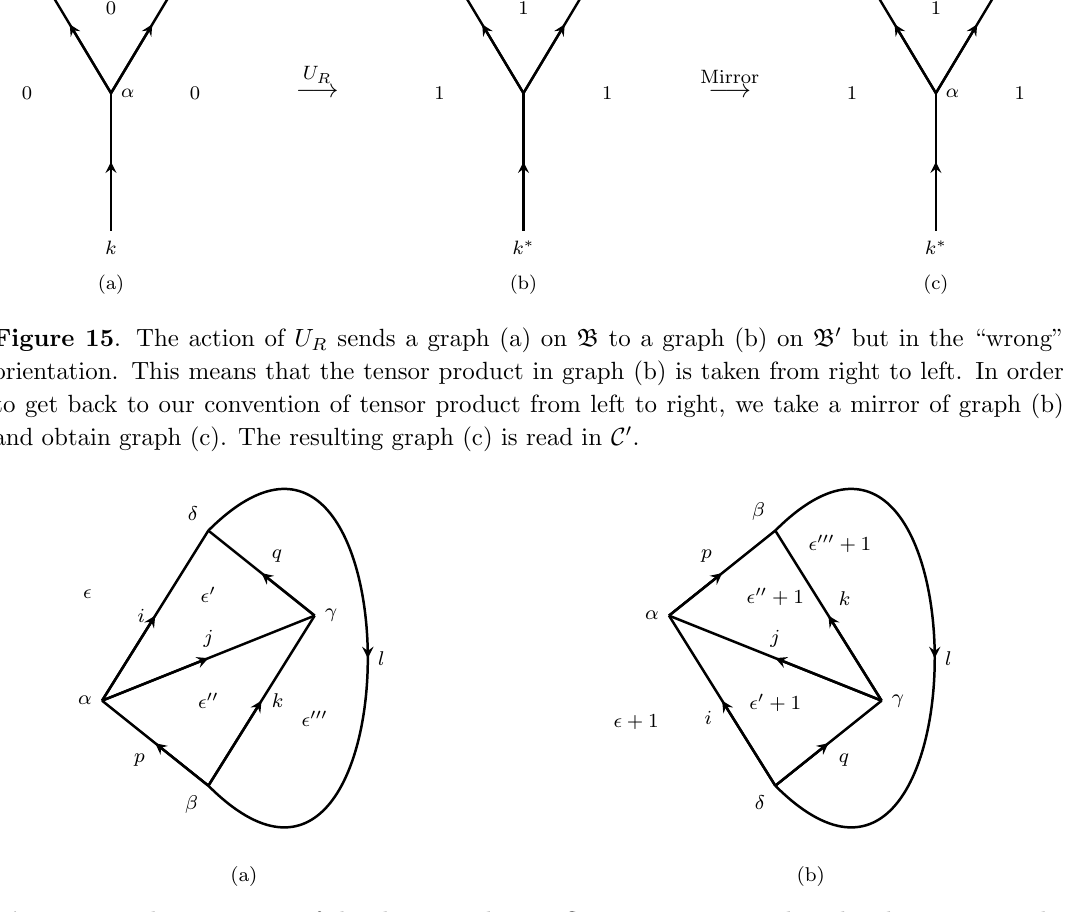
Figure 16 . The symmetry of the theory under a re(cid:13)ection guarantees that the above two graphs evaluate to the same